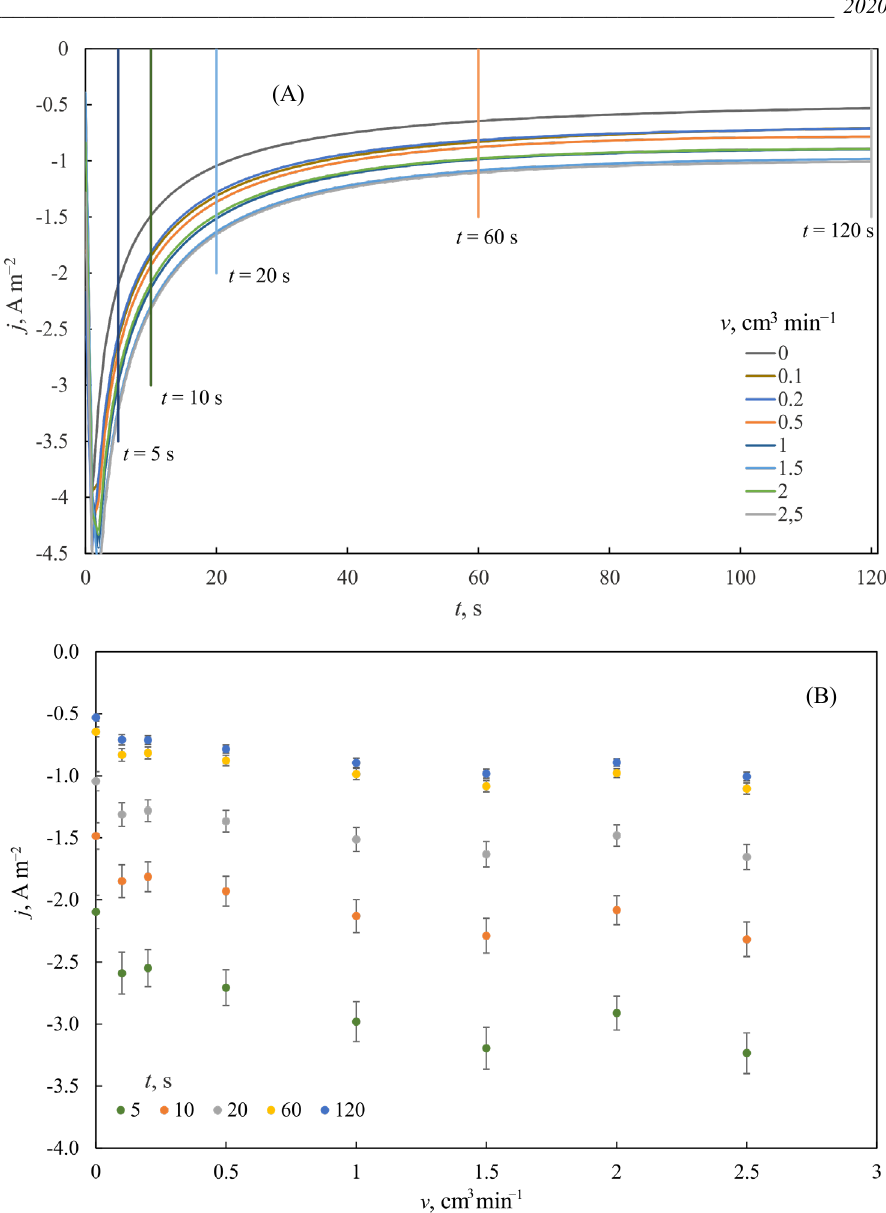
Fig. 4. (A) The dependence of the current density j on the time t and (B) the dependence of the current density on the pumping speed, v , at different moments during the chronoamperometry. The potential of the platinum electrode was stepped from 0.5 V to −0.5 V vs Ag|AgCl|0.1 M KCl. The 0.1 M KCl solution was saturated with 100 % oxygen ( p tot = 101